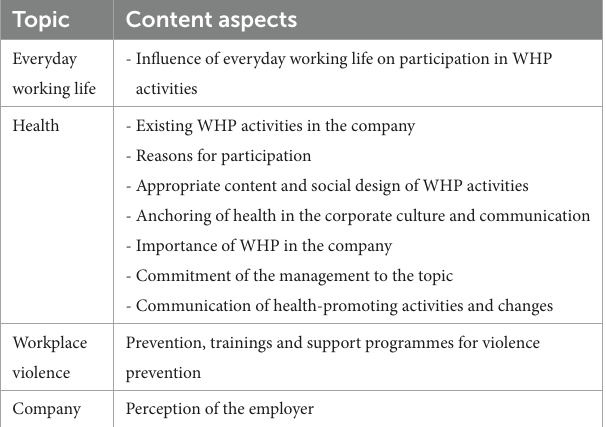
TABLE 2 Topics and content aspects of the interview guide.